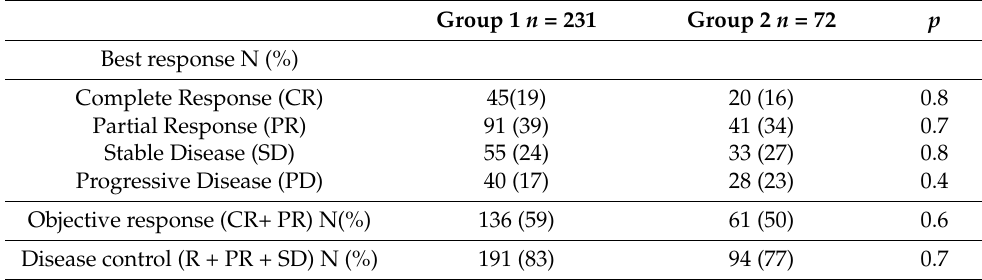
Figure 2. Overall survival. Median PFS were 7.8 M (CI: 6.4–9.9), 7.7 M (CI: 5.8–11.3), respectively in the two groups ( p = 0.4) (Figure 2). Similar results were found for groups 2a and 2b for OS or PFS. Objective RR were 59 and 50%, respectively ( p = 0.6) (Table 4). Table 4. Best response rates.